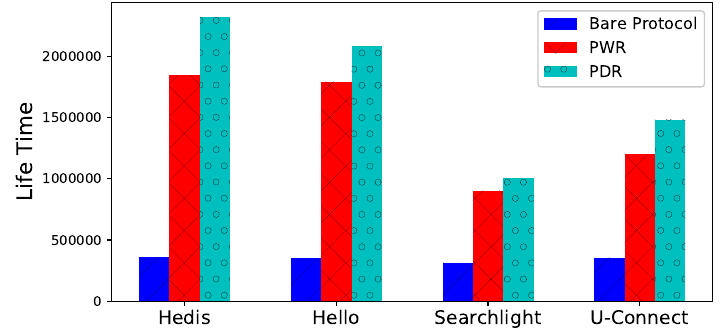
Figure 7. Spear prolongs the lifetime with PWR and PDR.